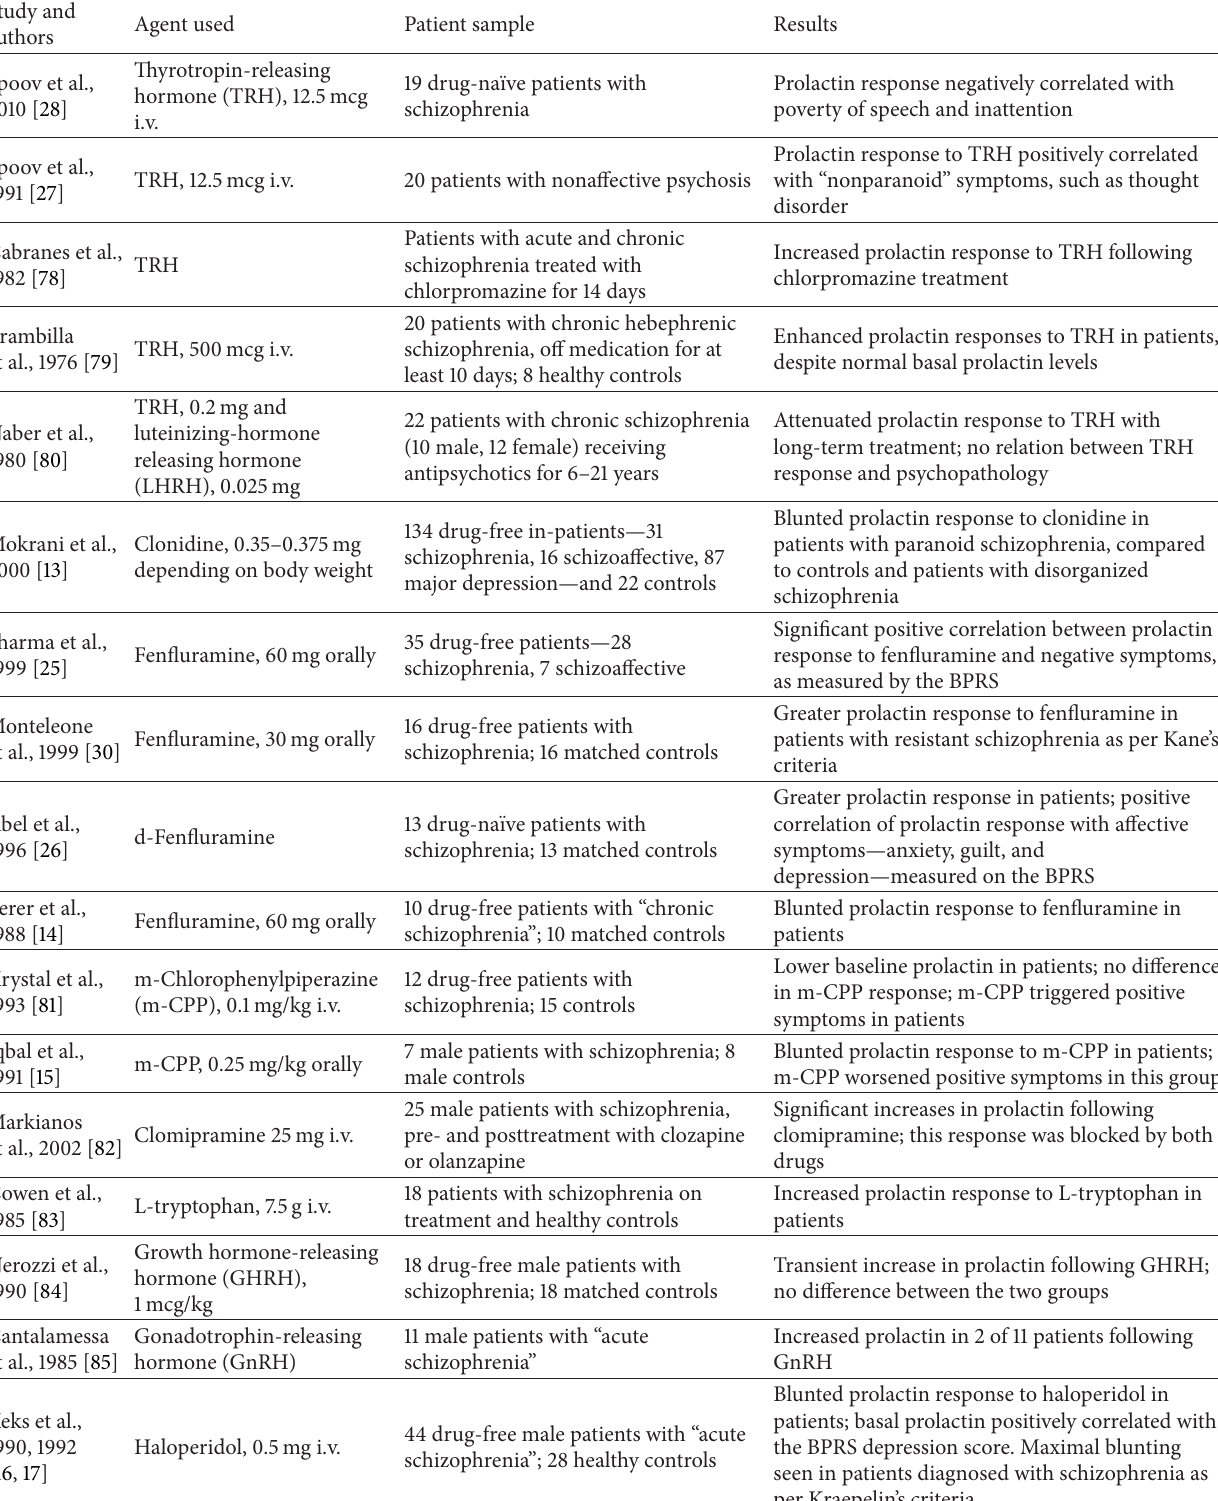
Table 3: Results of studies examining prolactin response to pharmacological challenges in